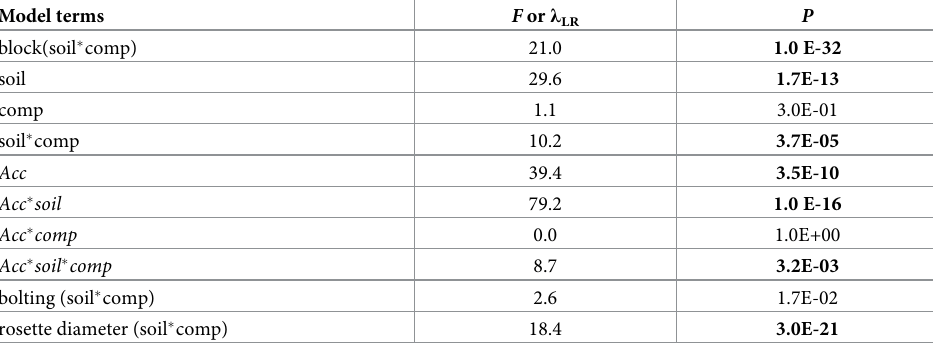
Bold P -values indicate significant effect after Bonferroni correction. λ LR : likelihood-ratio test statistic. ‘soil’: soils A, B and C. ‘comp’: absence or presence of P . annua . ‘Acc’: accession. ‘Bolting’: binary trait corresponding to the presence or absence of an inflorescence distinguishable from the leaves, on the day plants were scored for disease symptoms. ‘Rosette diameter’: maximal rosette diameter before the onset of